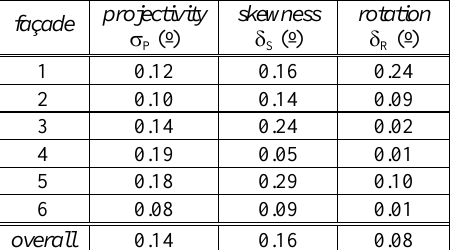
Table 1. Rectification results for the six façades.